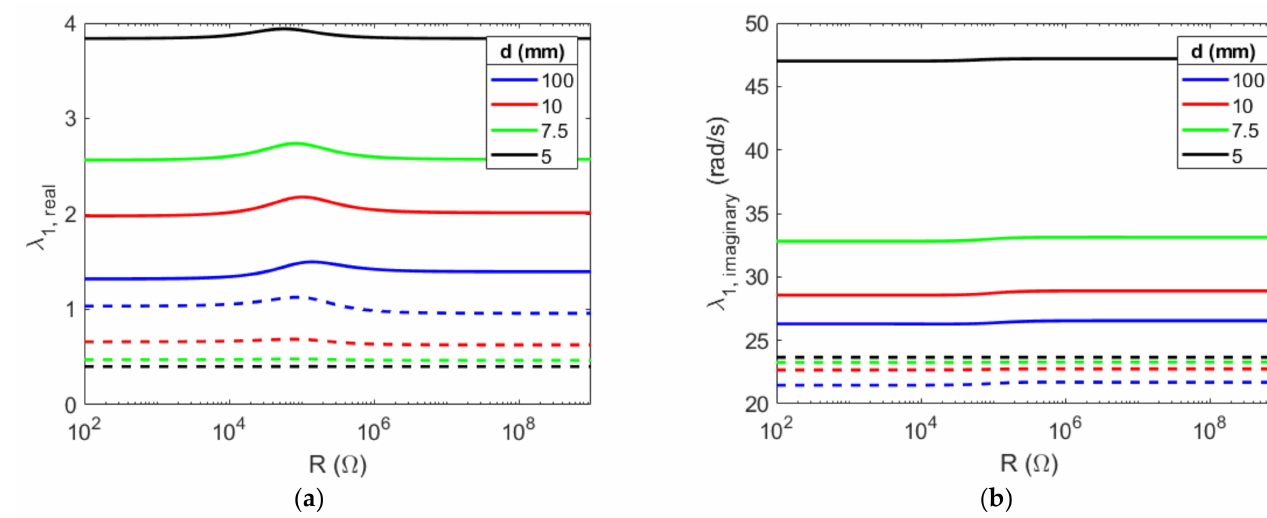
Figure 16. The load resistance effects with varying initial gap sizes on the ( a ) real and ( b ) imaginary